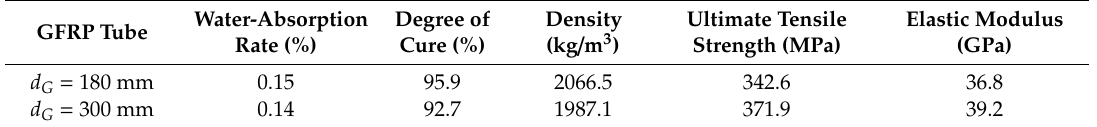
Table 2. Material properties of GFRP